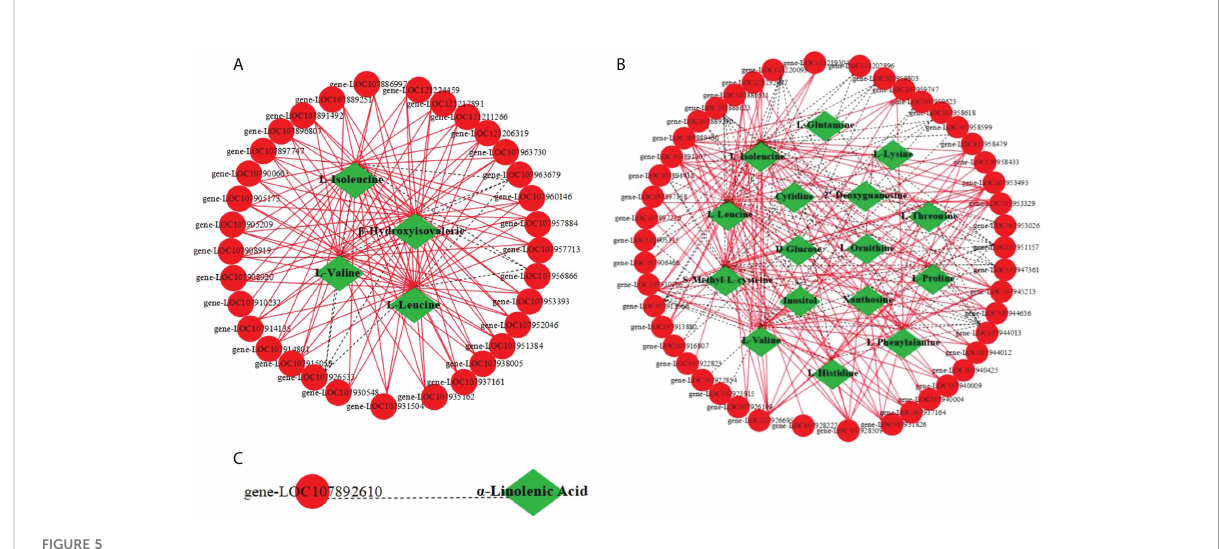
FIGURE 5 The network analysis of DEGs and DAMs in response to Cd stress and the addition of MT in cotton seedling leaves. (A) the correlation network of DEGs and DAMs involved in the pathway of valine, leucine and isoleucine degradation; (B) the correlation network of DEGs and DAMs involved in the pathway of ABC transporter; (C) , the correlation network of DEGs and DAMs involved in the pathway of alpha-linolenic acid metabolism; ● The red circle represents DEGs; ♦ the green square represents DAMs, the solid red line represents positive correlation, and the dashed black line represents negative